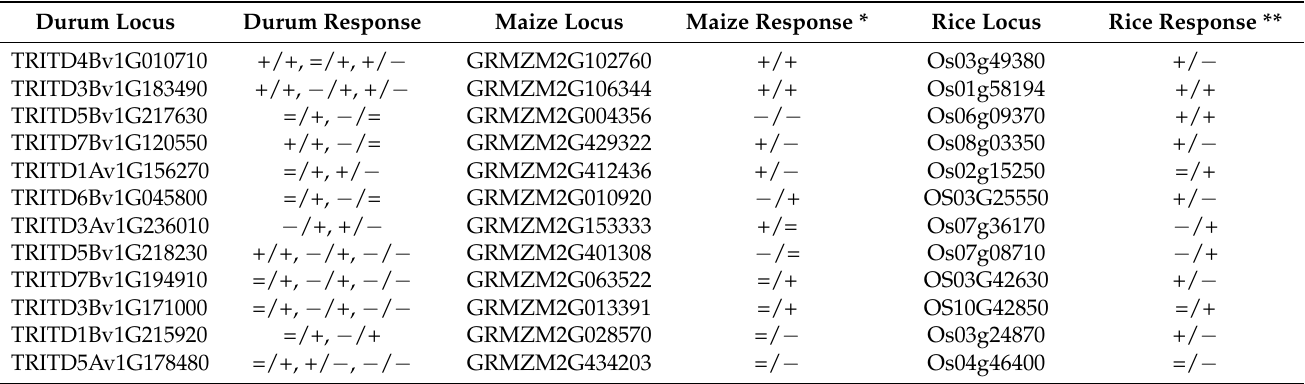
Table 2. Expression response during S1 and S2 stress stages for dehydration stress memory genes from durum wheat ( Triticum turgidum L. ssp. durum (Desf.)) and orthologs from maize ( Zea mays ) and rice ( Oryza sataiva